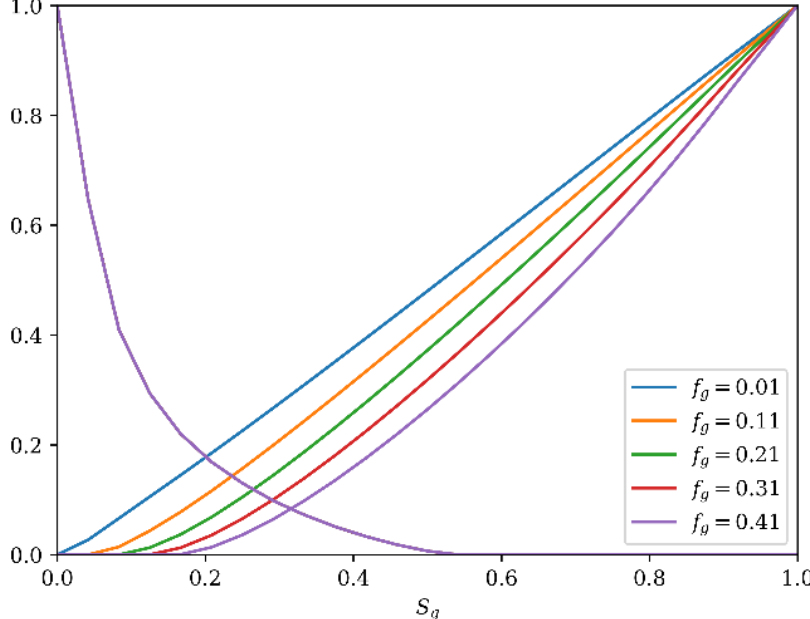
and ( left graph; (cid:0) (cid:1) f g and and 𝑆𝑆 𝑔𝑔𝑤𝑤 𝑓𝑓 𝑔𝑔 . 𝑆𝑆 𝑔𝑔𝑤𝑤 = 𝑆𝑆 𝑔𝑔𝑤𝑤 �𝑓𝑓 𝑔𝑔 � 𝑍𝑍 = 24